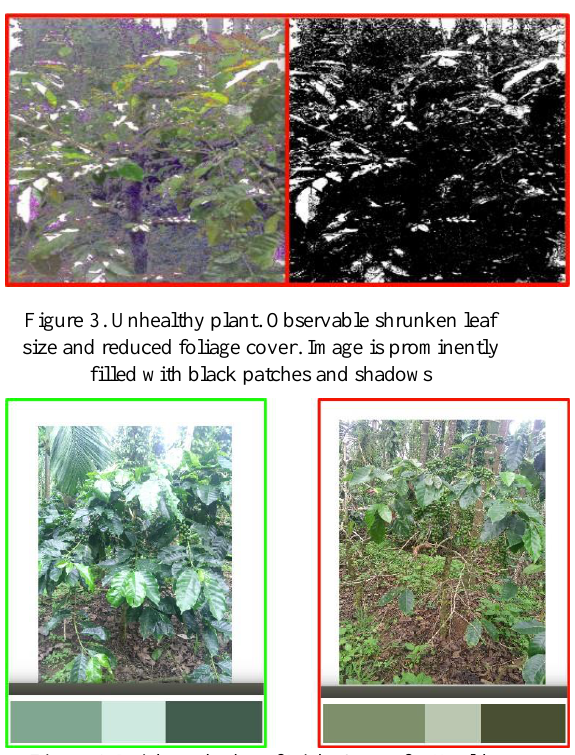
Figure 4. Brighter shades of Light Green for Healthy plants, Deeper shades of Brown and Dark Green for Unhealthy plants.